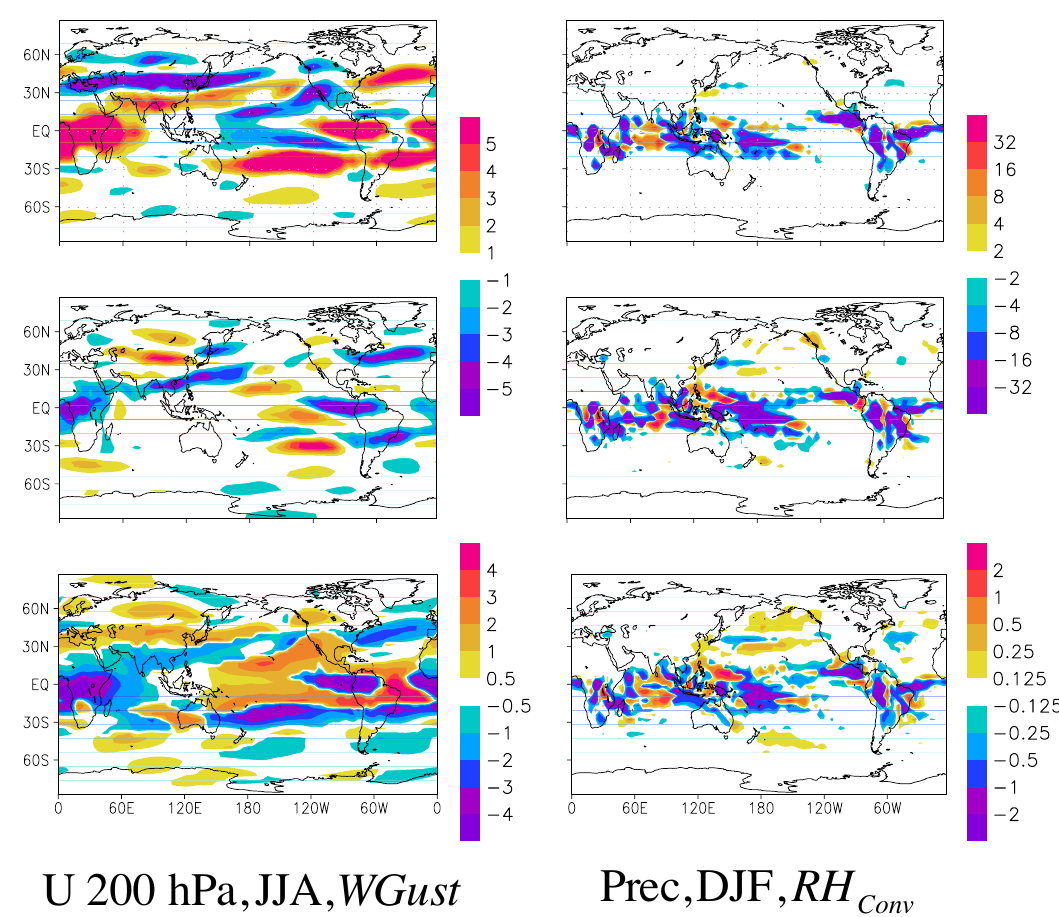
Fig. 13. Contributions to the analytic solution for the ensemble mean zonal wind at 200hPa in June–August in the WGust direction (left panels), and for precipitation in December–February in the RH Conv direction (right panels). Top panels: a i φ err normalized by the diagonal i . Middle panels: contribution 2 b ii φ err / h a 2 i (see Eq. 4). Bottom panels: the model error difference between µ i at its optimum contribution h a 2 i i ( µ i for the wind fields and µ i for precipitation), and at standard Max Min